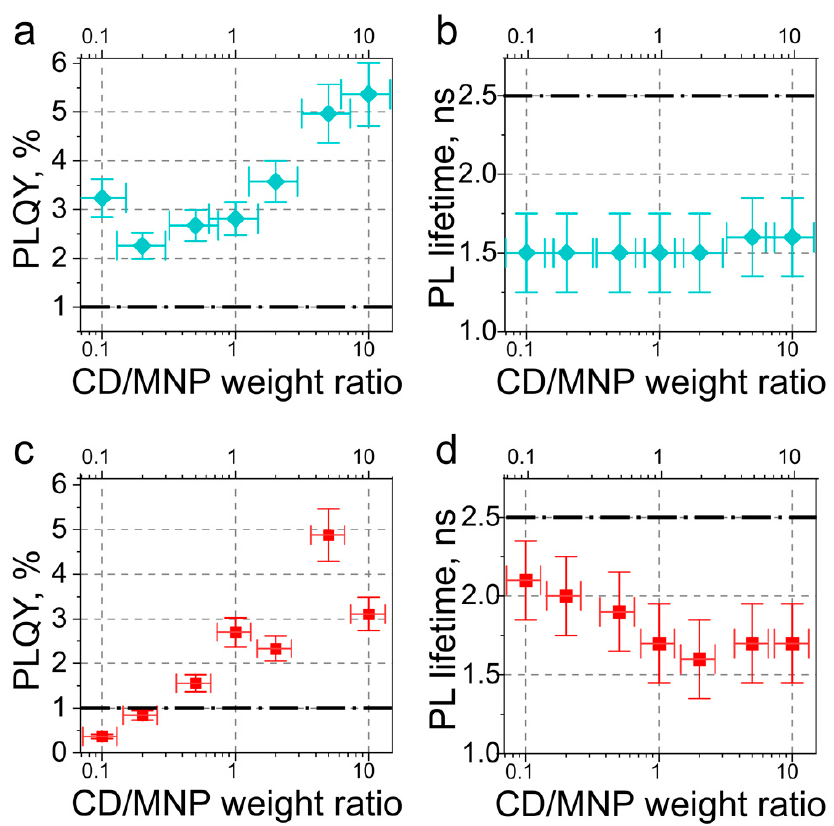
Figure 5. Optical properties of ( a , b ) CD–AgNP complexes and ( c , d ) CD–AuNP complexes. PL QY ( a , c ) and average PL lifetime ( b , d ) versus CD/MNP weight ratios. Dash-dot lines in ( a , c ) and ( b , d ) provide the values of PL QY and PL lifetime for the pristine CD-3, respectively. A schematic illustration of the electronic transitions of CDs in the close vicinity of plasmonic MNPs is given in a Jablonski diagram in Figure 6a. For the pristine CD-3, the relaxation of the lowest excited state ( S 1 ) can occur both through radiative ( Γ ) and nonradiative ( k nr ) processes with PL QY CD = Γ / ( Γ + k nr ) . The estimated Γ and k nr values for CDs are equal to 4.0 × 10 6 and 3.9 × 10 8 s − 1 , respectively. If the CD’s in- trinsic radiative decay rate remained unchanged in the CD–MNP complex, the change in PL QY can be attributed to the changes in k nr , or to the plasmon-induced enhance- ment of Γ . The plasmon-induced radiative recombination rate, Γ m , shortened the PL lifetime and affected the PL QY of the fluorophore near the metal surface according to PL QY CD − MNP = ( Γ + Γ m ) / ( Γ + Γ m + k nr ) . This enhancement is related to the increase in the PL intensity of the CDs before the non-radiative energy dissipation, and it is more pronounced for fluorophores with low PL QYs [22]. Moreover, one should consider the PL quenching by reabsorption and/or near-field plasmonic dissipation prevailing the radiative relaxation of a fluorophore, and to account for this factor, another nonradiative constant, k m , should be taken into account when estimating the PL QY of CD–MNP